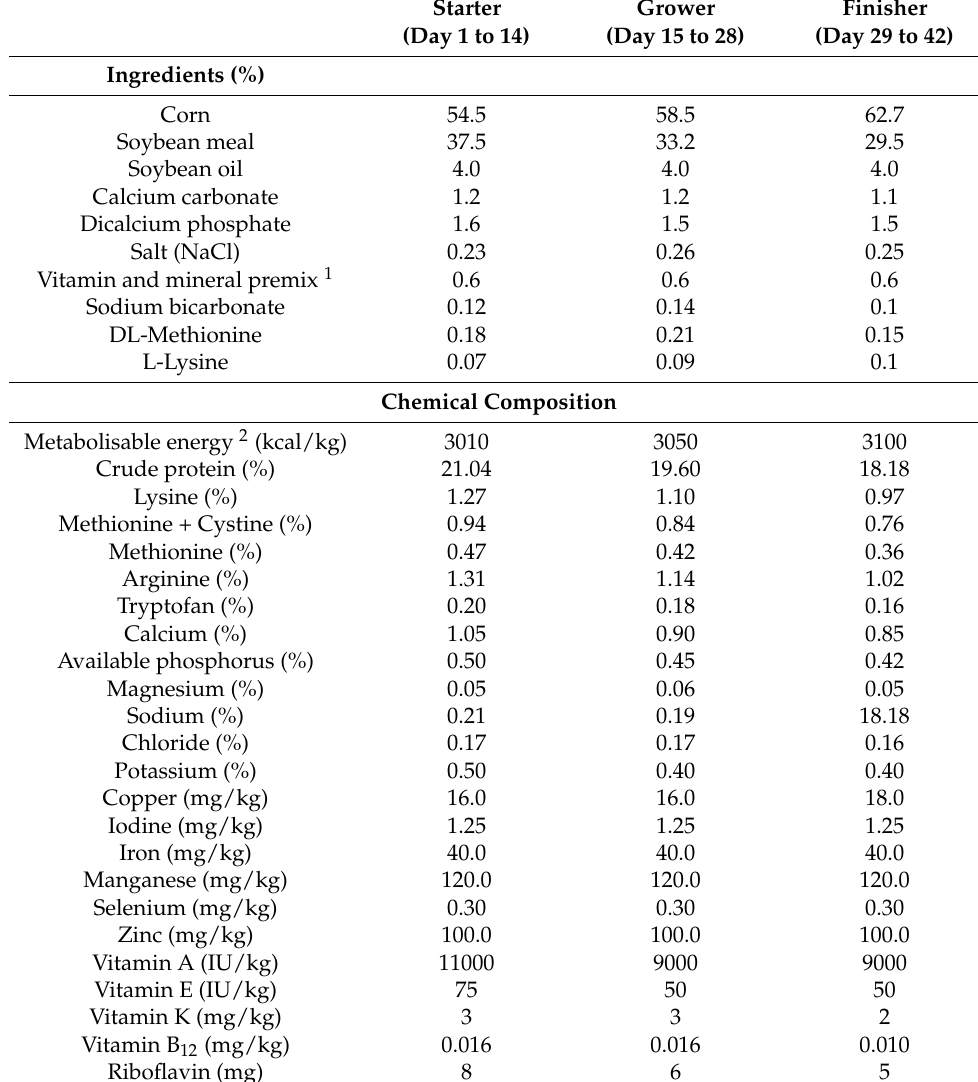
Table 1. Ingredients, chemical composition and metabolizable energy of the starter, grower and finisher diets 1